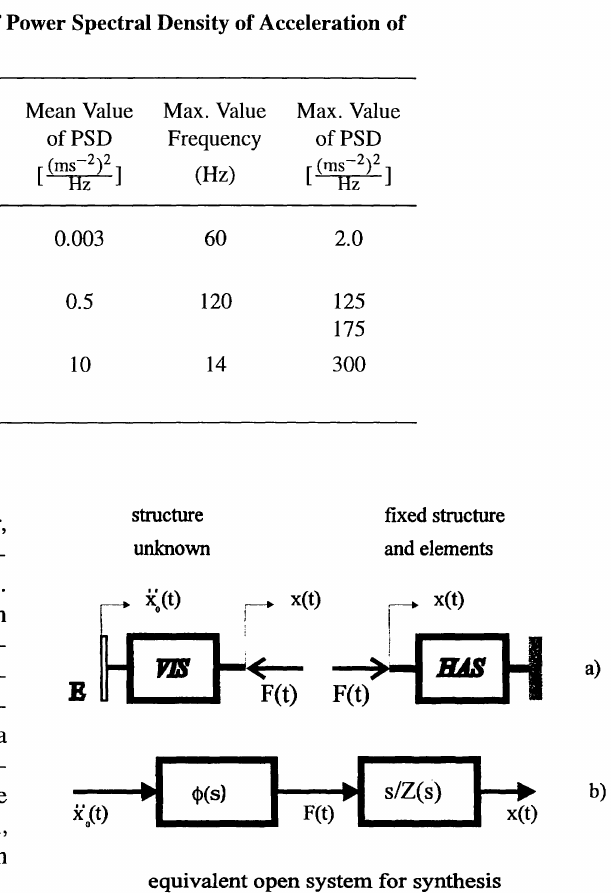
Table 1. Approximate Parameters of Power Spectral Density of Acceleration of